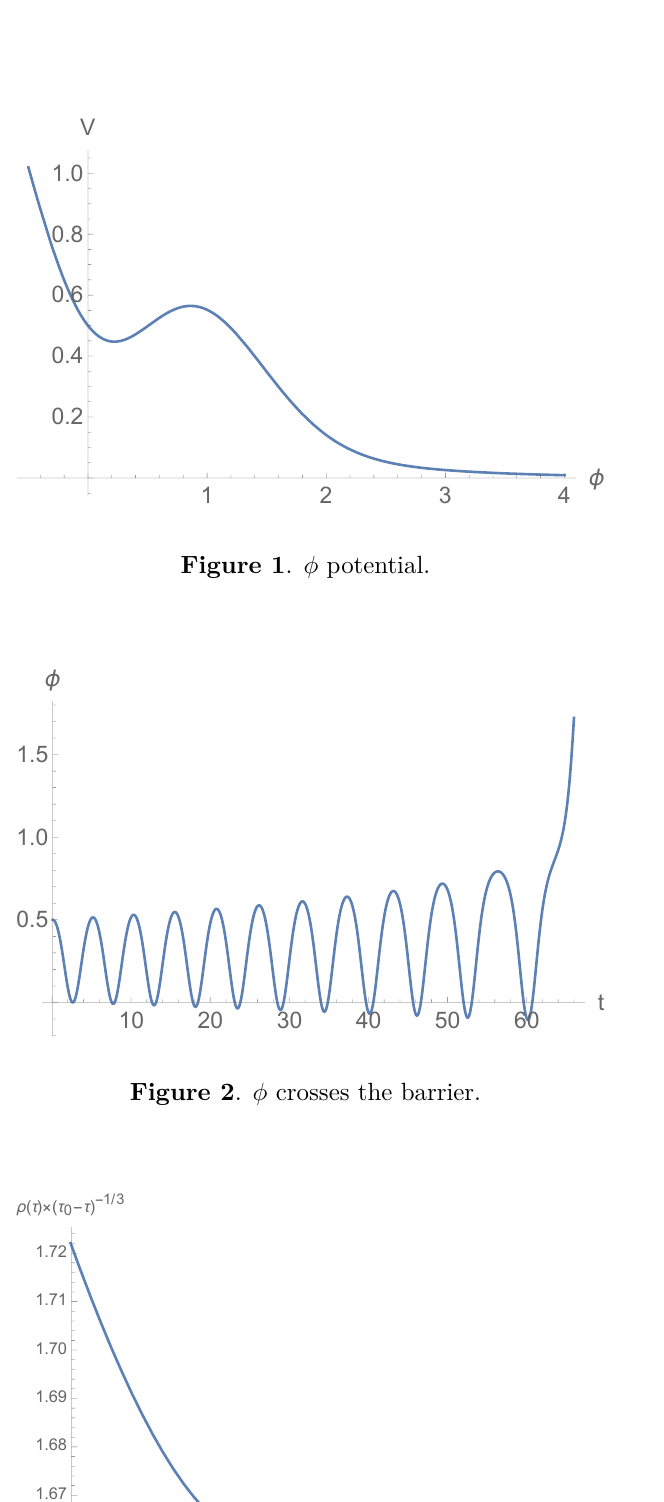
Figure 3 . ρ ( τ ) ∼ ( τ 0 − τ ) 1 / 3 ; τ 0 ≈ 159 . 5